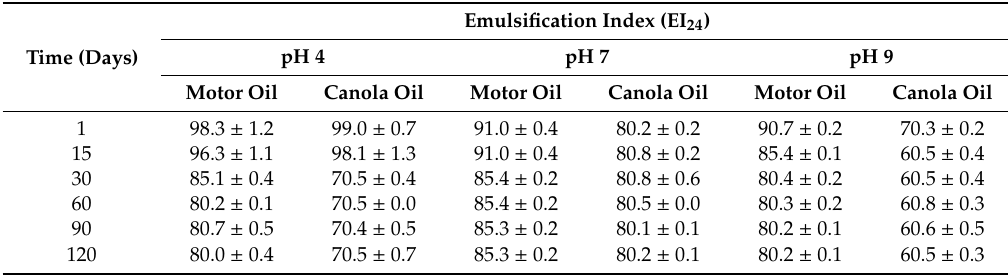
Table 5. Emulsification of motor oil and canola oil stability for 120 days on acid, neutral, and alkaline pH conditions (data expressed as mean ± standard deviation).